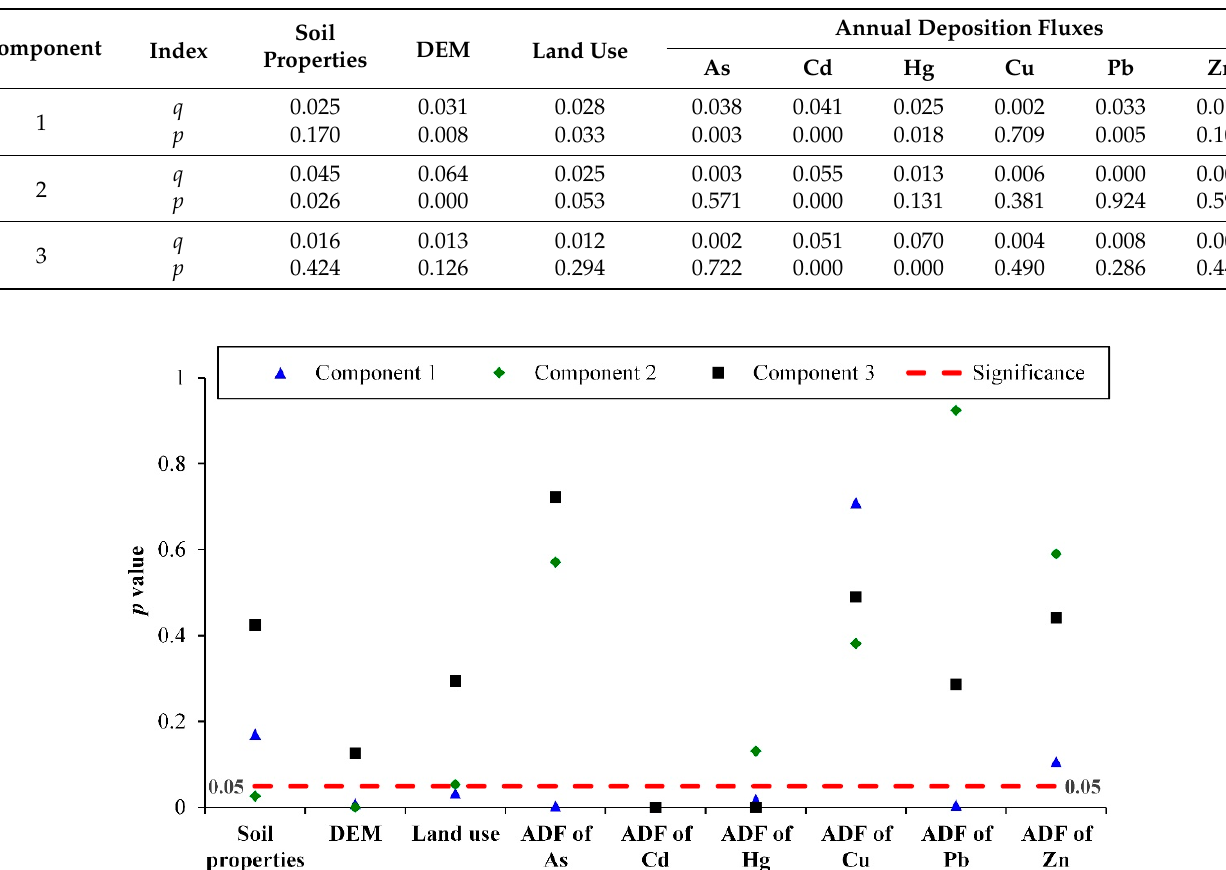
Figure 5. The p values of influencing factors on heavy metal concentrations at the multi-object level: ADF, annual deposition flux.